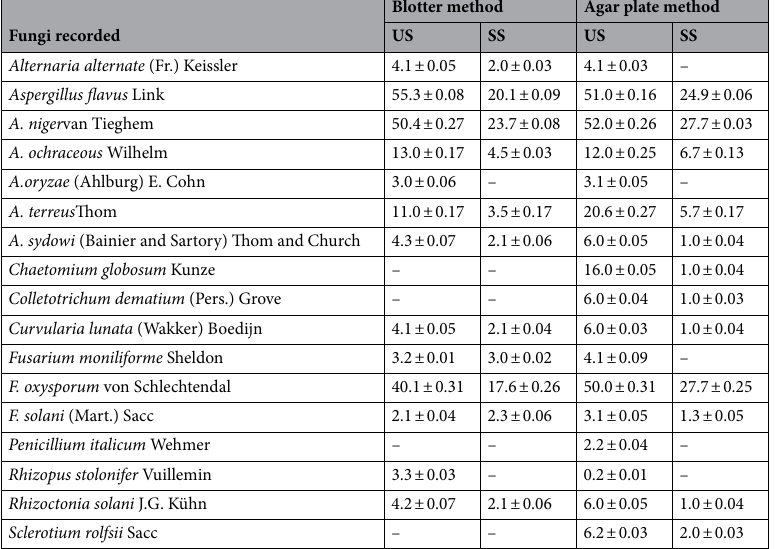
Table 1. Mycological analysis of stored food seeds of chickpea. US unsterilized seeds, SS sterilized seeds, SD standard deviation. –Absence of fungal species. *Values given are mean of three replicates.